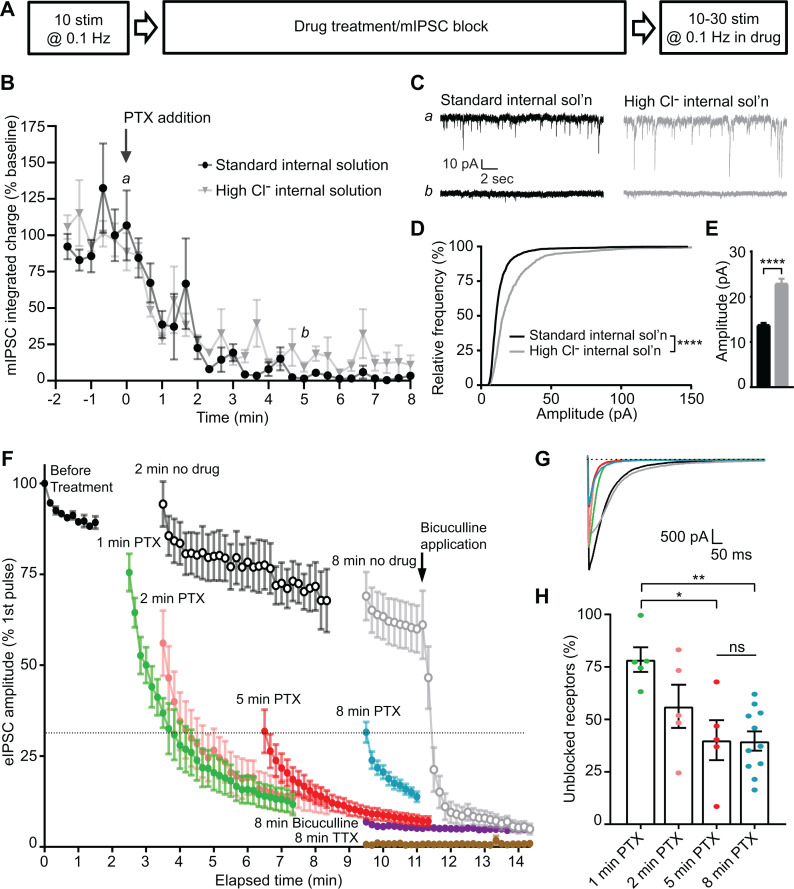
Evoked and spontaneous neurotransmission are partly segregated at inhibitory synapses.(A) Schematic showing experiment design. (B) Time course indicating mIPSC block following the addition of PTX measured using standard internal solution (black) or high Cl- internal solution (gray). Integrated charge is binned in 20 s intervals. PTX diminished mIPSC frequency within 5 min. This time course is unchanged when measured using a high Cl- internal solution. (C) Example traces of mIPSC recordings from indicated time points in B. (D) Cumulative histogram of spontaneous event amplitudes in standard and high Cl- internal solutions. High Cl- internal solution shifted the distribution of mIPSCs toward higher amplitudes (Kolmogrov-Smirnov test D = 0.3350, p<0.0001, n = 1200 events from 12 standard internal solution recordings and 600 events from six high Cl- internal solution recordings, 100 events randomly selected per recording). (E) Average of spontaneous event amplitudes in standard and high Cl- internal solutions. High Cl- internal solution increased the average amplitude of mIPSC events (unpaired t-test t(1798) = 10.96, p<0.0001, n = 1200 events from 12 standard internal solution recordings and 600 events from six high Cl- internal solution recordings, 100 events randomly selected per recording). (F) Evoked inhibitory response to stimulation before drug treatment and following: no drug (open symbols, n = 6 for 2 min, n = 7 for 8 min), 1–8 min PTX (n = 5 for 1 min, n = 5 for 2 min, n = 5 for 5 min, n = 11 for 8 min), 8 min bicuculline (n = 4), or 8 min TTX treatment (n = 3). Treatment of the 8 min no drug condition with bicuculline after the 10th stimulation drastically reduced the response amplitude down to the level of 8 min bicuculline treatment, indicating that the measured response is mediated through GABAARs. Treatment with PTX for increasing amounts of time decreased the initial evoked response to stimulation, which continued to decay upon successive stimulations in all cases. However, initial evoked response was not further decreased after a 5 min treatment with PTX. (G) Example traces of initial evoked response after PTX treatment or rest (black = 2 min no PTX, gray = 8 min no PTX, green = 1 min PTX, pink = 2 min PTX, red = 5 min PTX, blue = 8 min PTX). (H) Quantification of the percent of the initial evoked response that is mediated by GABAARs which are unblocked following PTX treatment. Values are adjusted for bicuculline baseline and no drug treatment maximum response. After 5 min in PTX, when all receptors activated by mIPSCs are blocked, the unblocked evoked response is 40.1 ± 9.6% of the maximum response. This response is not further decreased following an 8 min treatment with PTX (39.7 ± 4.6%; one-way ANOVA F(3,22) = 6.228, p=0.0032, Tukey’s post-hoc testing 1 min vs 2 minutes p=0.2260, 1 min vs 5 minutes p=0.0124, 1 min vs 8 minutes p=0.0028, 5 min vs 8 minutes p>0.9999, n = 5 for 1 min, n = 5 for 2 min, n = 5 for 5 min, n = 11 for 8 min). Graphs are mean ± SEM. * indicates p<0.05, ** indicates p<0.01, **** indicates p<0.0001, ns indicates not significant.Figure 3—source data 1.Source data for Figure 3.